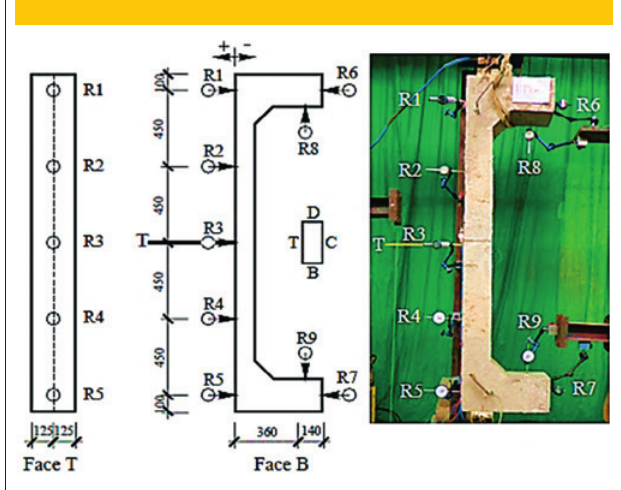
Figure 6 – Strain gauge positioning on steel longitudinal reinforcement, on compressed